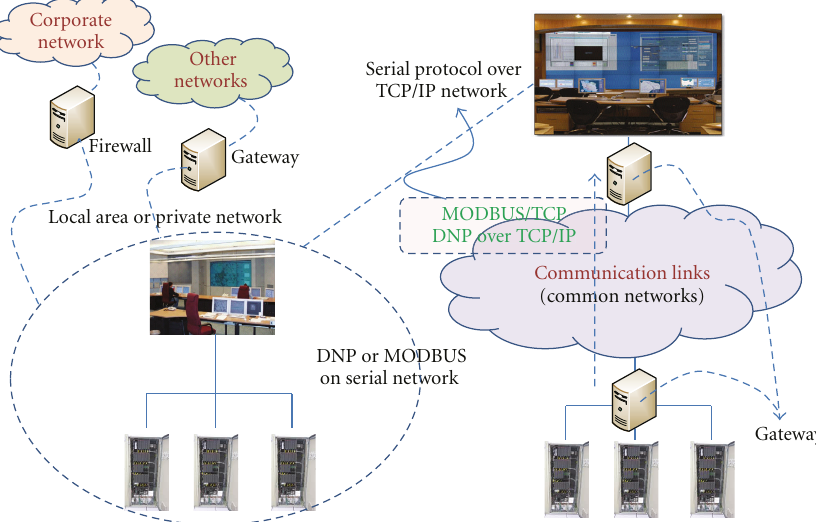
Figure 2: Smart grid vision [3].